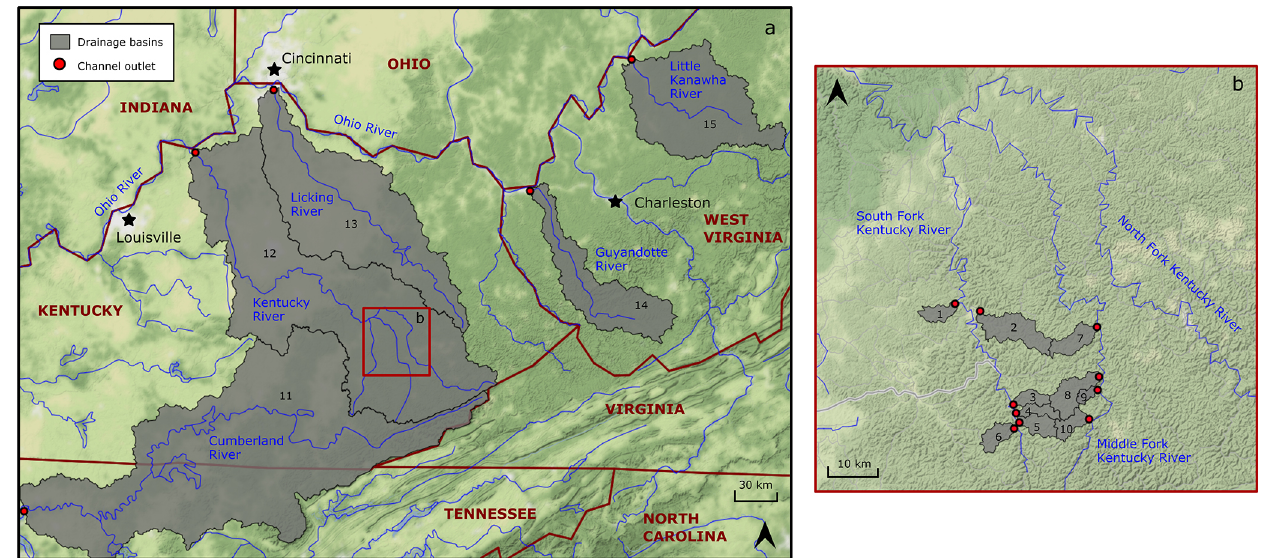
Figure 11. Location of the sites for width–area analysis in the Cumberland and Allegheny Plateaus, southwestern Appalachians, USA. (a) Large rivers in the Cumberland and Allegheny plateaus; (b) small creeks in the Cumberland Plateau. The red circles mark the outlet of each catchment analysed, labelled 1–15. The tributary where the north and south forks of the Kentucky River join is located at 37.57017, − 83.71071 (WGS84). Map tiles by Stamen Design under CC BY 3.0; data © OpenStreetMap contributors. Distributed under the Open Data Commons Open Database License (ODbL)